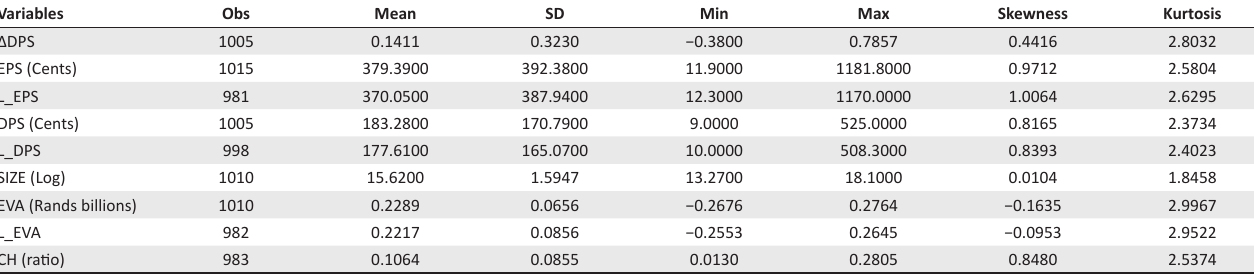
TABLE 2: Descriptive analysis for all variables of Panel 1-Full sample. Variables